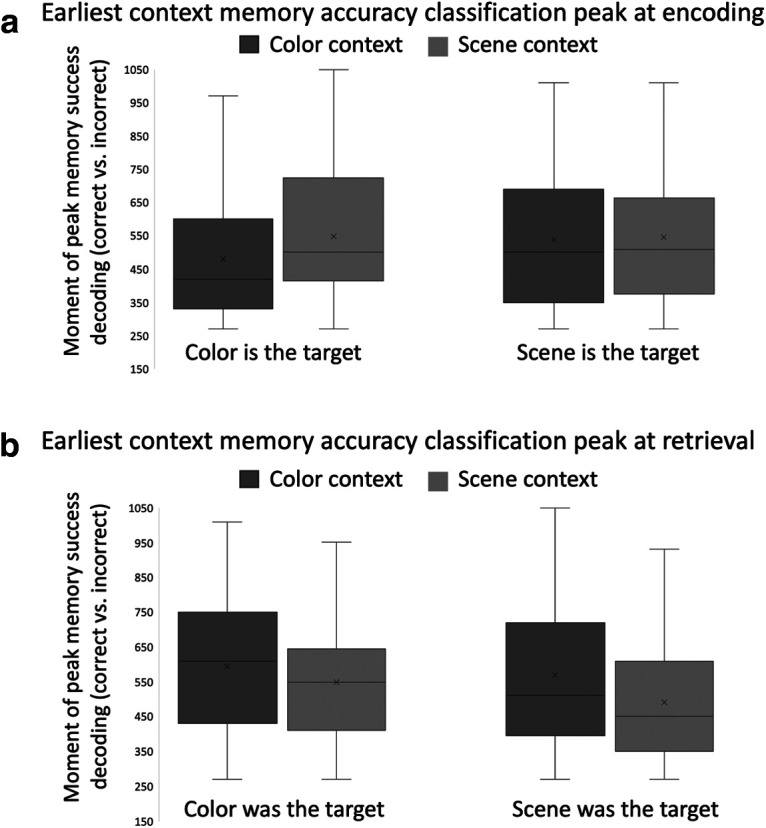
The earliest peaks of the context memory accuracy (correct vs incorrect) classification averaged across participants at (a) encoding and (b) retrieval. At each stage of the experiment, we divided the trials based on the target at encoding. We performed a set of MVPAs to discriminate context (i.e., color or scene) correct and incorrect trials for each attention condition and memory phase; × indicates the condition means while the horizontal lines indicate the medians.